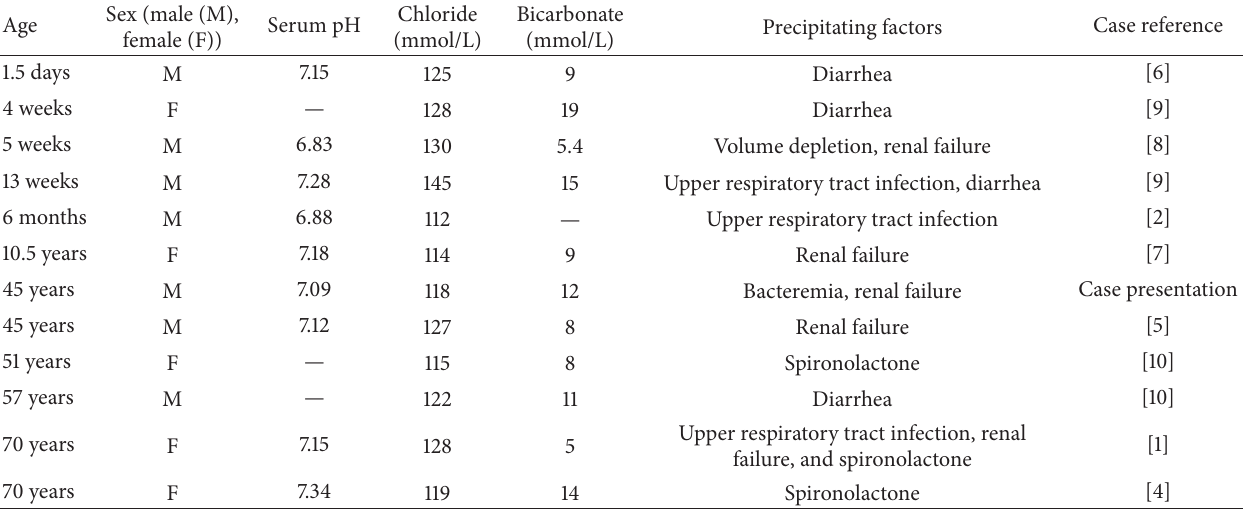
Table 1: Summary of the literature describing cholestyramine-induced hyperchloremic metabolic